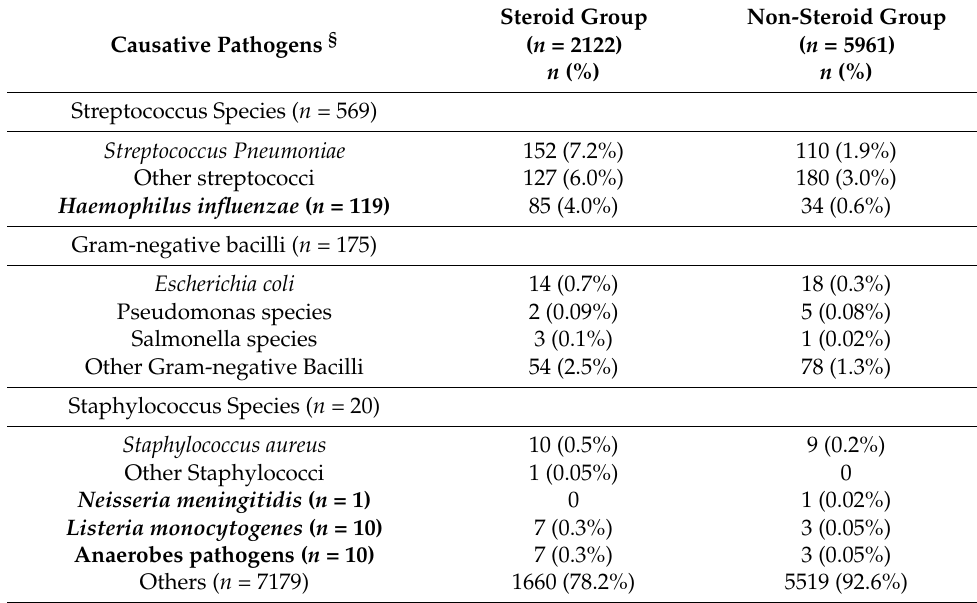
Table 2. Causative